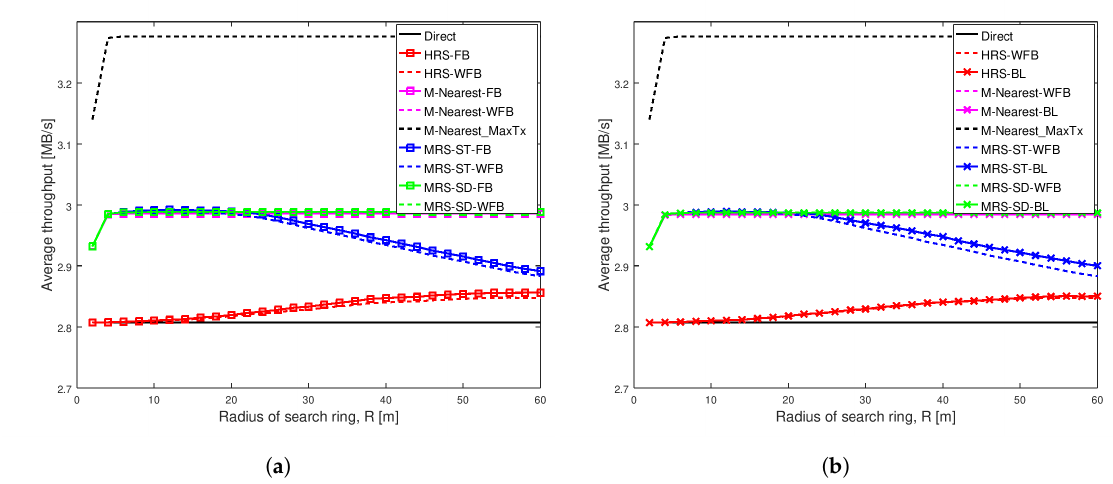
Figure 3. Average throughput of different schemes when Shape = 1.001 and Scale = 0.001 in a network having width of 100 m. ( a ) Different battery power levels not considered in relay selection; ( b ) Different battery power levels considered in relay